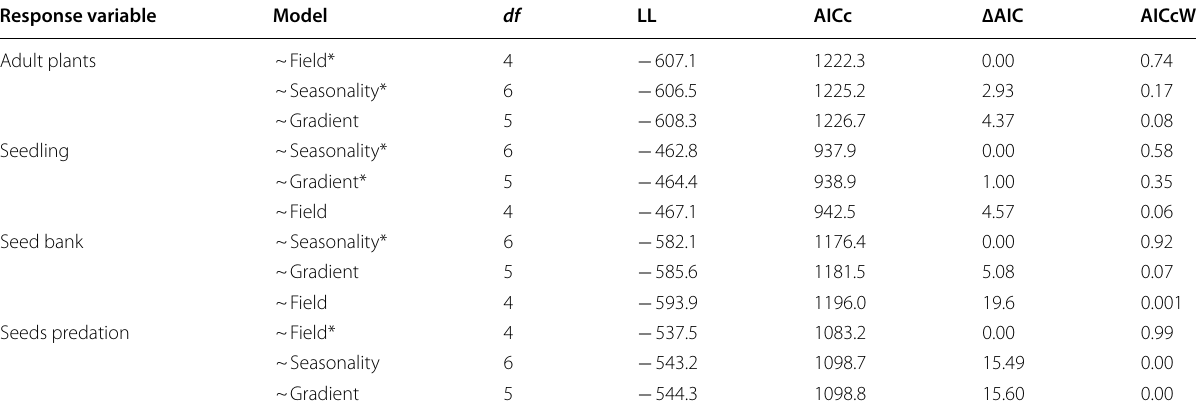
Table 2 Candidate linear mixed effect models predicting the main effects of seasonal flood disturbance (Seasonality), type of grasslands (Field), and topographical conditions (Gradient) on growth stages of population (adults and seedling) and population- related ecological processes (seed bank and predation) based on most suitable error distribution and link function (linear mixed effects